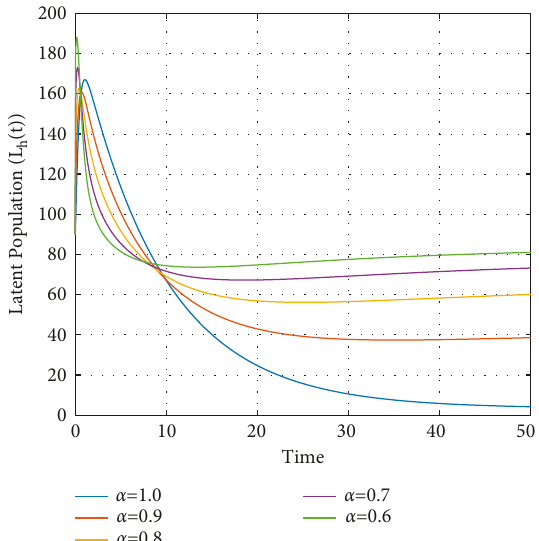
� 0 . 011, β � 0 . 005, 1 2 � 0 . 05, c � 0 . 05, c � 0 . 05, 1 2 3